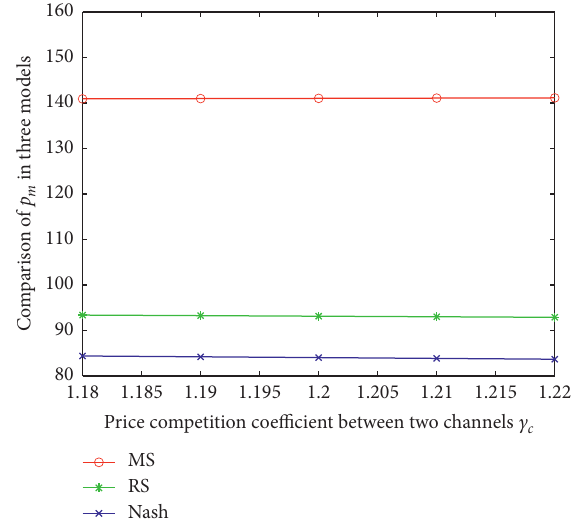
Figure 5: The comparison of the optimal wholesale price of standard products w in the three